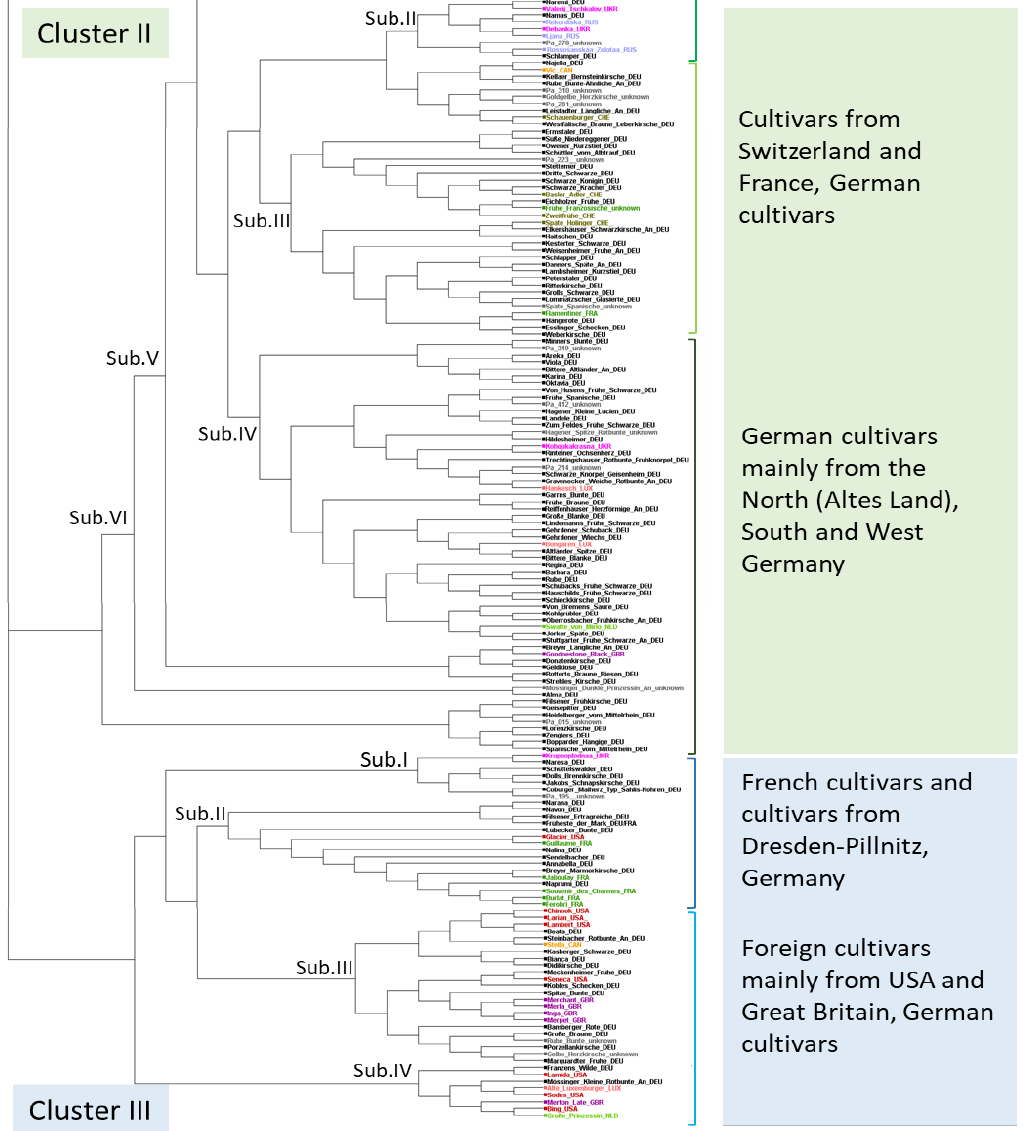
Figure 4. Phylogenetic relationships among sweet cherry cultivars from the German cherry genebank, based on genetic data of 16 SSR markers. The phylogenetic tree is estimated based on the dissimilarity distance matrix of the SSR data of the 383 genotypes, considering a bootstrap analysis with 1000 replications. The cherry cultivars are labeled according to their country of origin, as follows: black: Germany (DEU); yellow: Canada (CAN); red: USA (USA); green: France (FRA); purple: Great Britain (GBR); rosa: Luxembourg (LUX); bright green: The Netherlands (NLD); pink: Ukraine (UKR); olive: Switzerland (CHE); lavender: Russia (RUS); bright blue: Hungary (HUN); blue: Sweden (SWD); grey-blue: Italy (ITA); dark red: Czechia (CZE); gray: unknown origin.